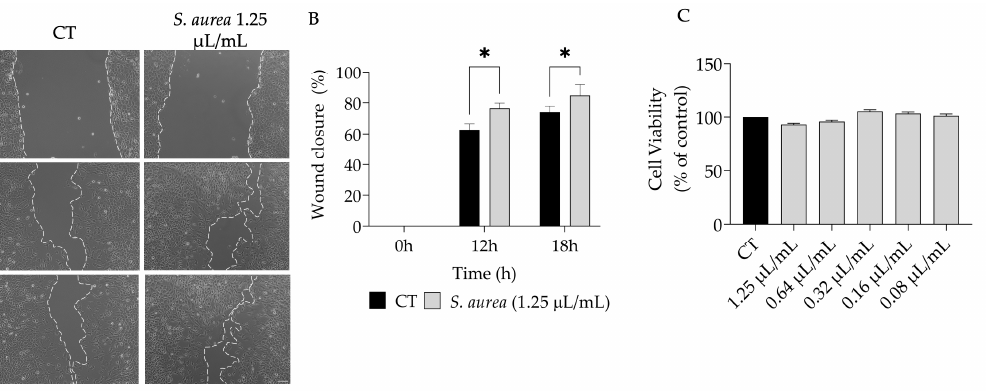
Figure 3. Effect of S. aurea essential oil on wound healing. ( A ) Shows a representative phase-contrast image of NIH 3T3 fibroblasts, respectively, in the absence (CT) and presence of S. aurea EO (1.25